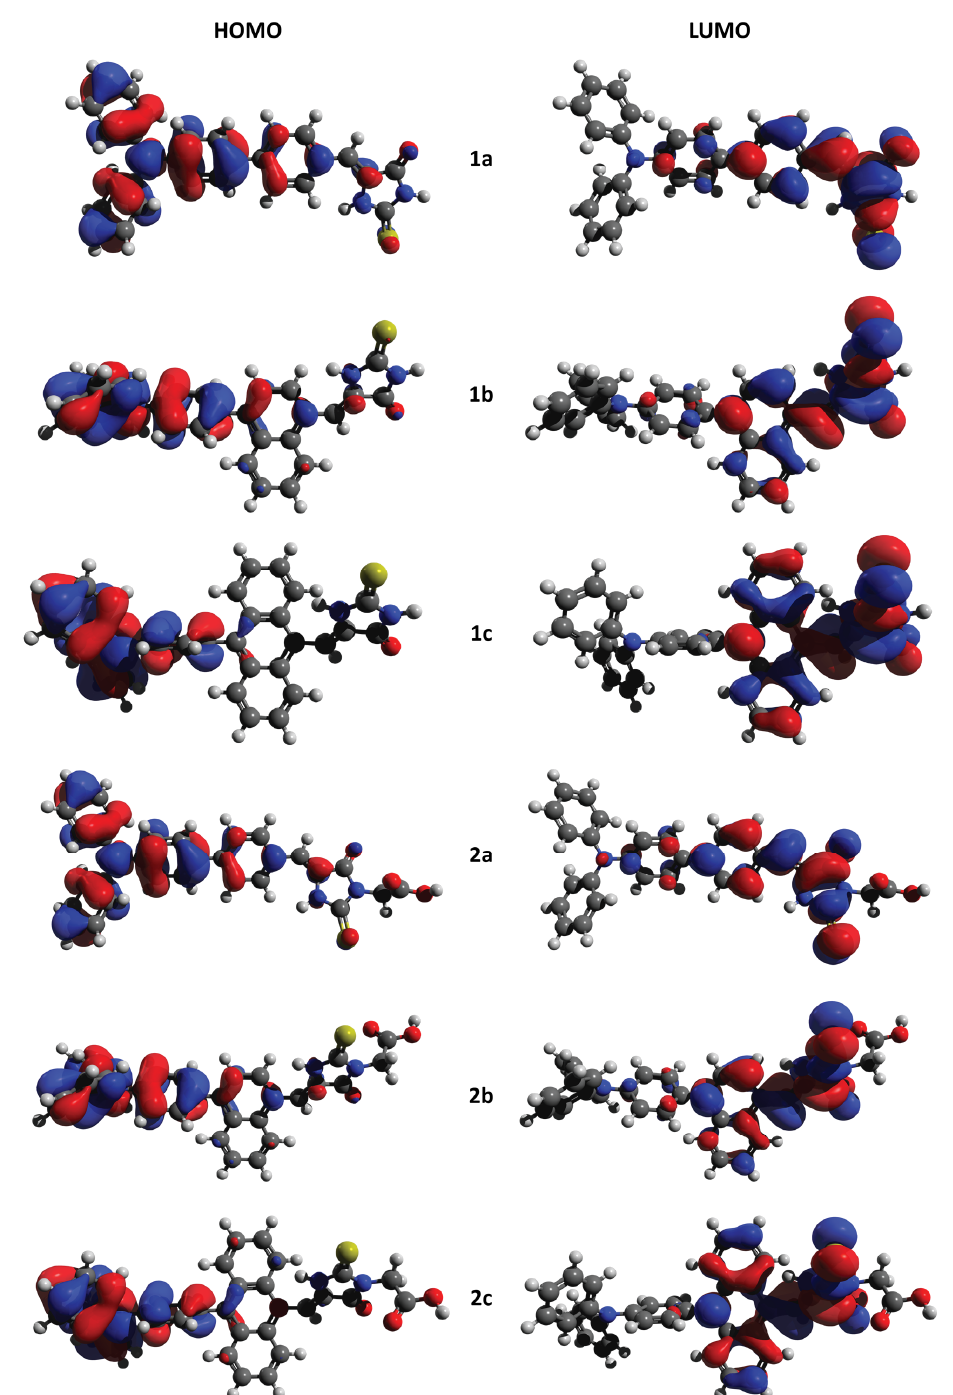
Figure 2. Visualization of HOMO and LUMO orbitals calculated for the examined molecules.